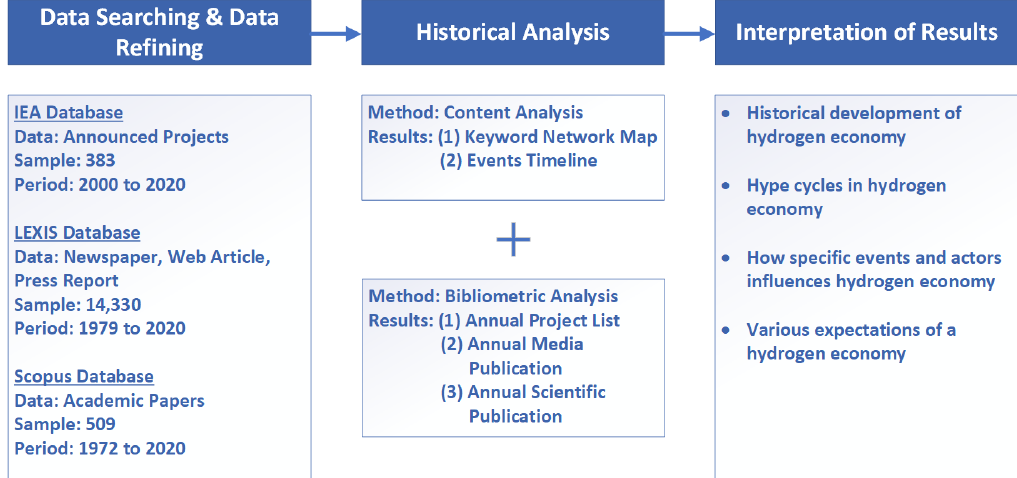
Figure 1. Research